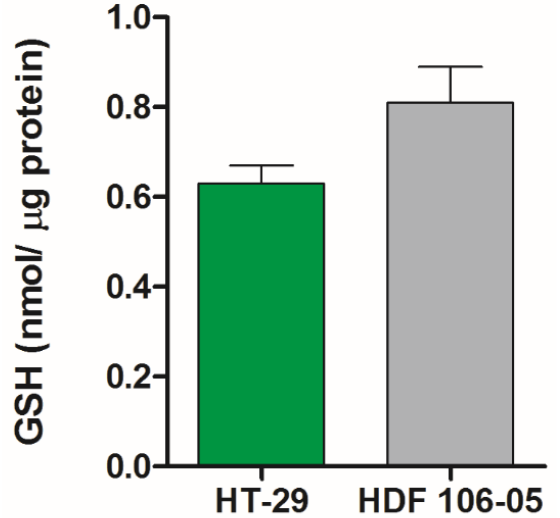
Figure 4. Intracellular GSH levels according to cell type. The total glutathione level of HT-29 and HDF 106-05 cells at a basal level, i.e., untreated cells, was analyzed using the Glutathione Assay Kit (Sigma-Aldrich) according to the manufacturer’s instructions and the GSH content (nmol) was normalized to the protein content (μg) of the sample.